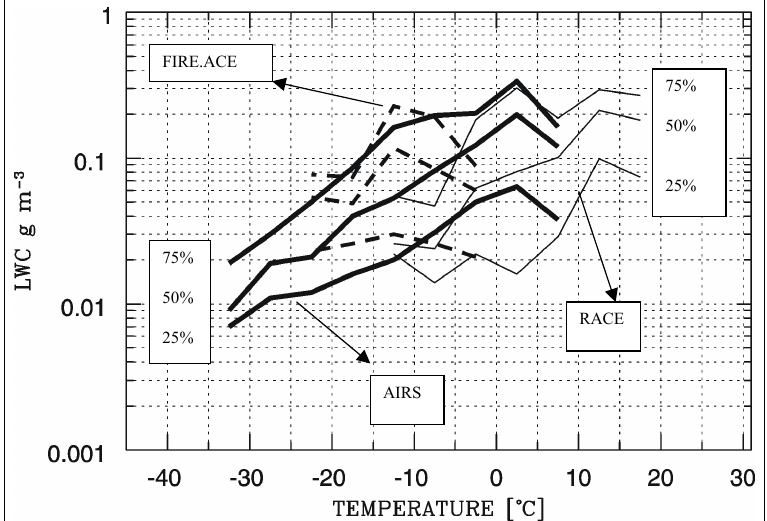
Fig. 1. Frequency of occurrence of LWC over 5 ◦ C intervals versus T for each project. Each set of curves in- cludes the 25, 50, and 75 percentiles.